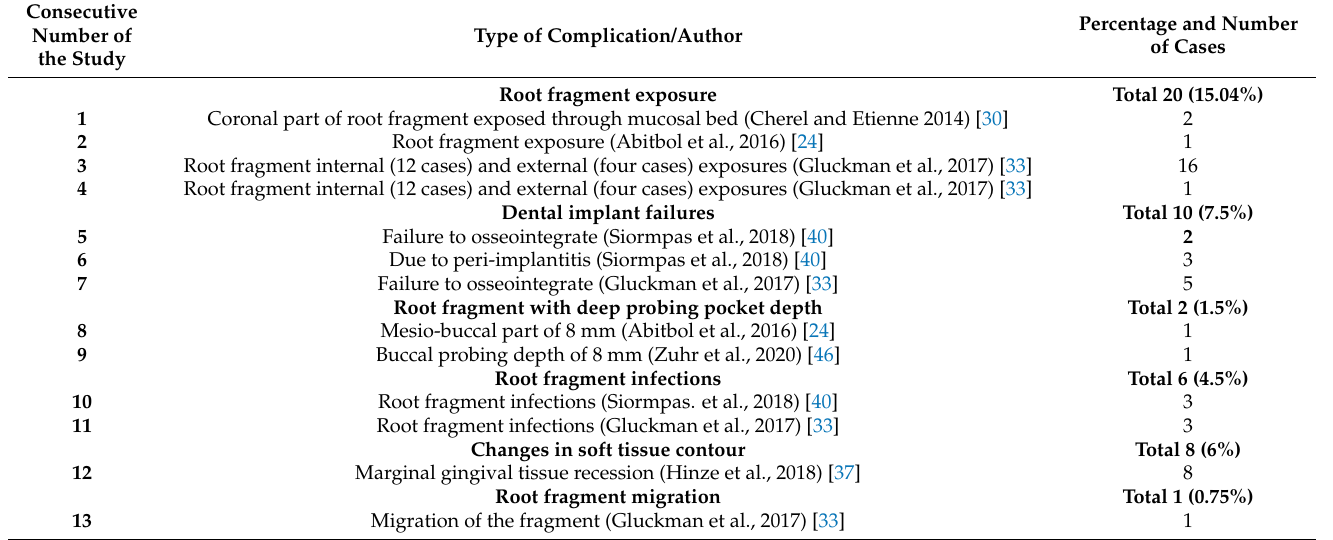
Table 4. The frequency and percentage distribution of the dental implant failures and complications and undesired adverse effects of immediate dental implant placement in conjunction with the socket-shield technique of the included clinical